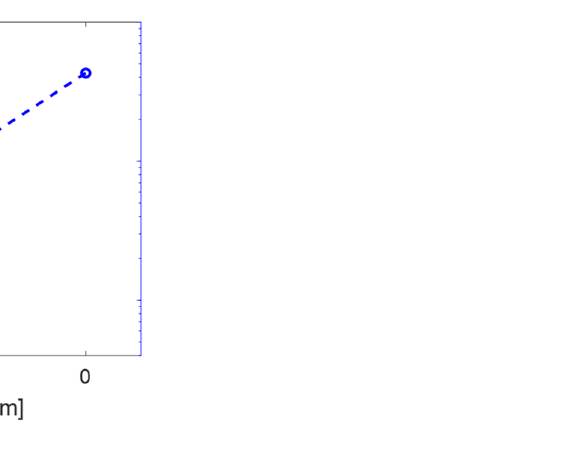
Figure 1. Scaling of the transition NA with